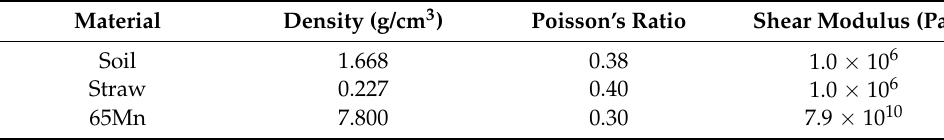
Figure 4. Straw model. Table 2. Material physical properties parameters.